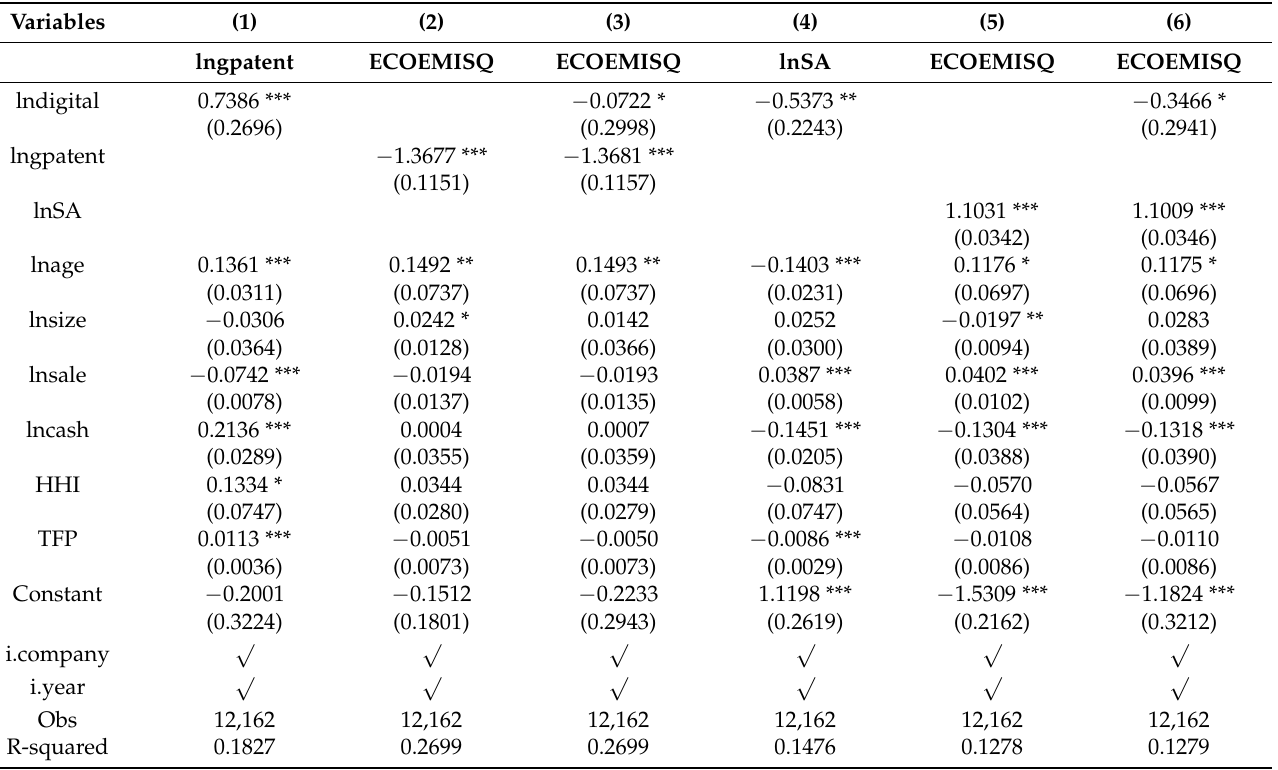
Table 10. Green technology